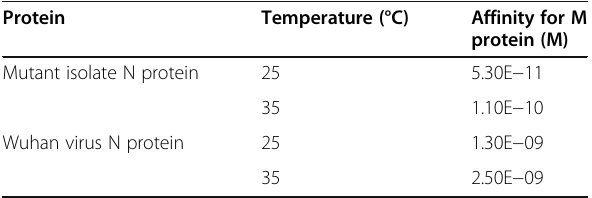
Table 3 The affinity for the mutant and wild type N proteins for the M protein at 25 and 35 °C. As it can be seen, the mutant appears to display more temperature sensitivity than the wild type, with its affinity for the M protein decreasing over this